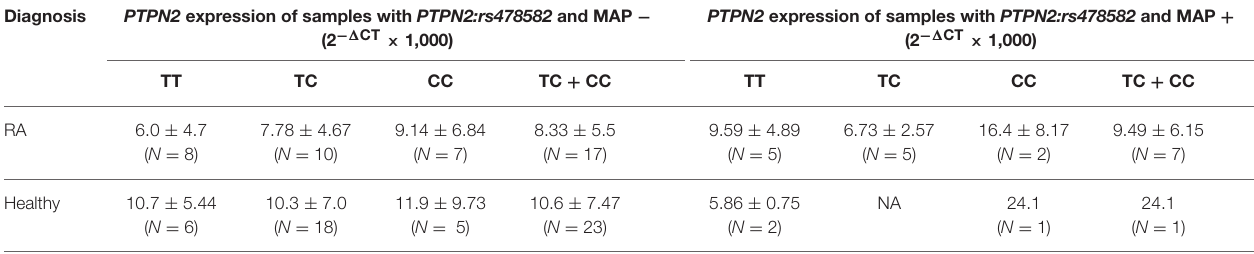
TABLE 4 | Effect of combined PTPN2:rs478582 and MAP presence on PTPN2 expression. Diagnosis